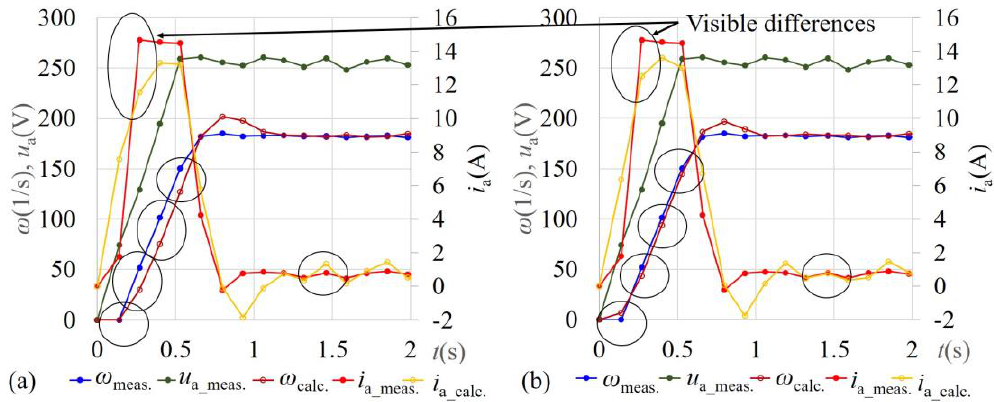
Figure 10. Measured and calculated responses in the case of MD3 using: ( a ) EM; ( b ) RK.